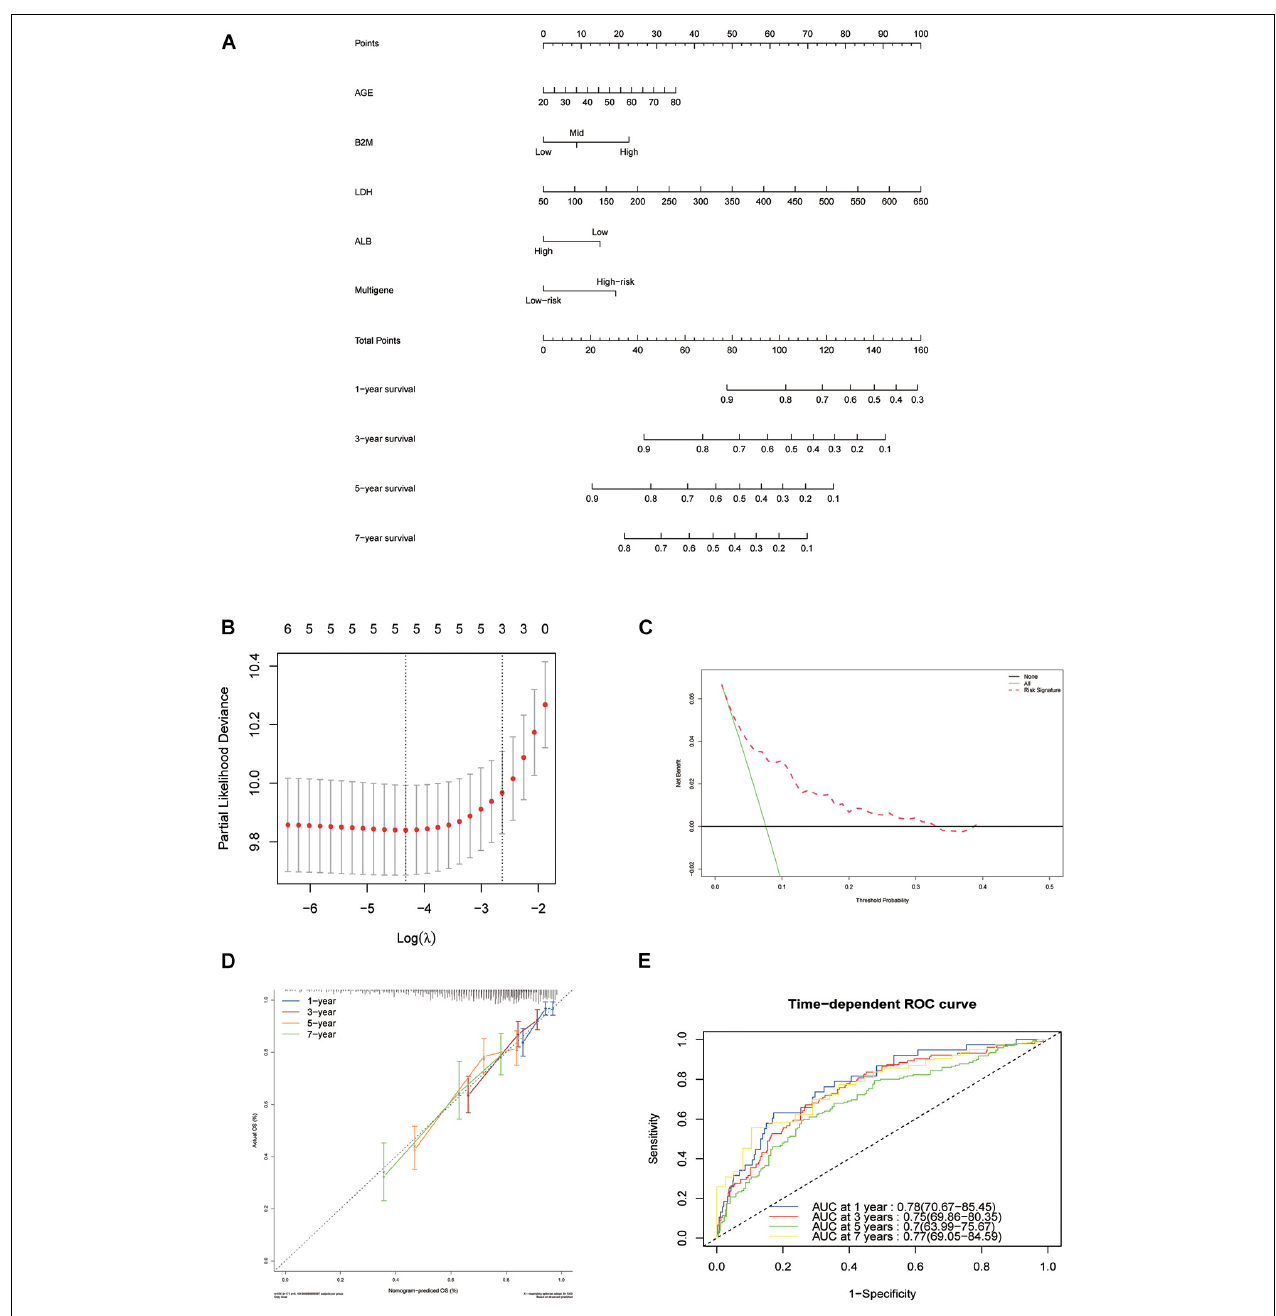
FIGURE 6 | Nomogram construction based on the eight-gene signature and prognostic value of genes. (A) The nomogram for predicting the proportion of patients with 1-, 3-, 5-, and 7-year OS of MM. (B) LASSO regression analysis used tenfold cross-validation via the maximum criteria. (C) Decision curve analysis of nomogram predicting 1-, 3-, 5-, and 7-year OS of MM. (D) Calibration plots of the nomogram. (E) Time-dependent ROC analysis of nomogram predicting 1-, 3-, 5-, and 7-year OS of